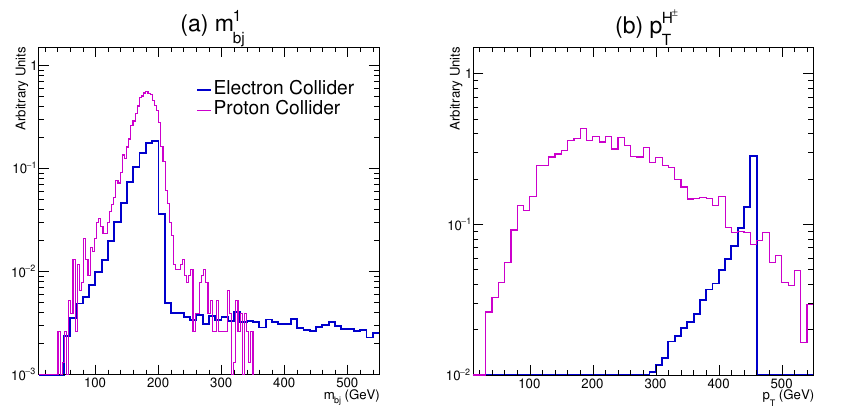
, and (b) p H ± at truth level from e + e − → T bj √ ¯ b ¯ cb (magenta) at s = 14 TeV af-